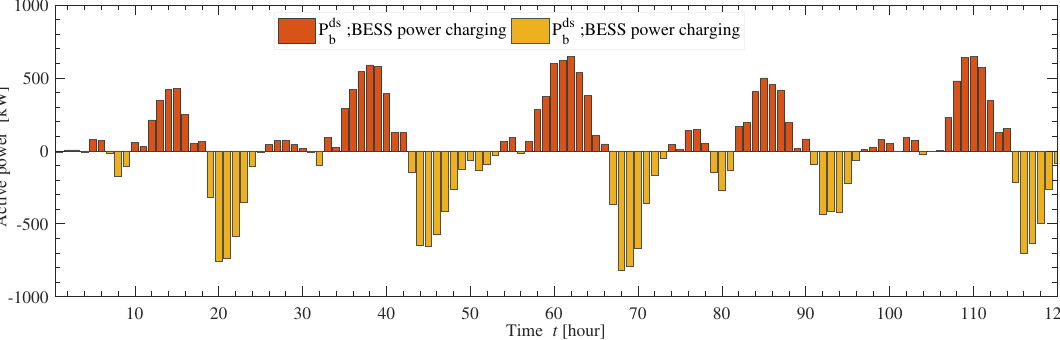
Figure 10. BESS charging and discharging dynamics (case 2).